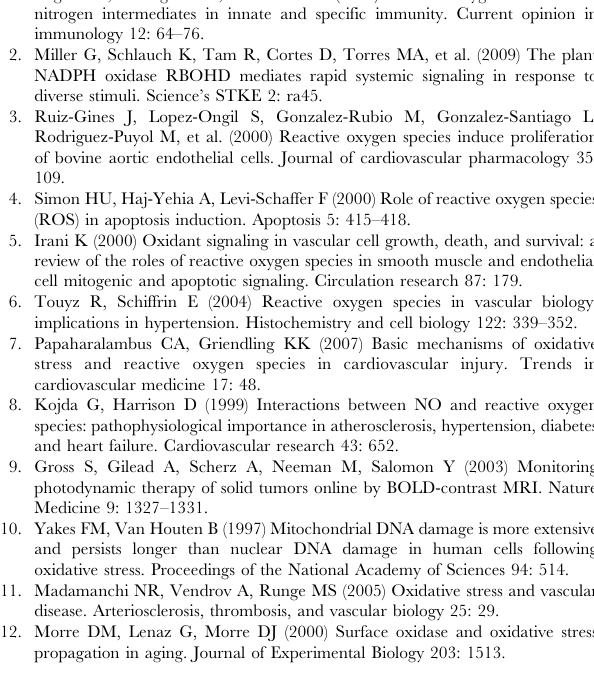
Figure S2 bEnd.3 cell line tube formation assay.